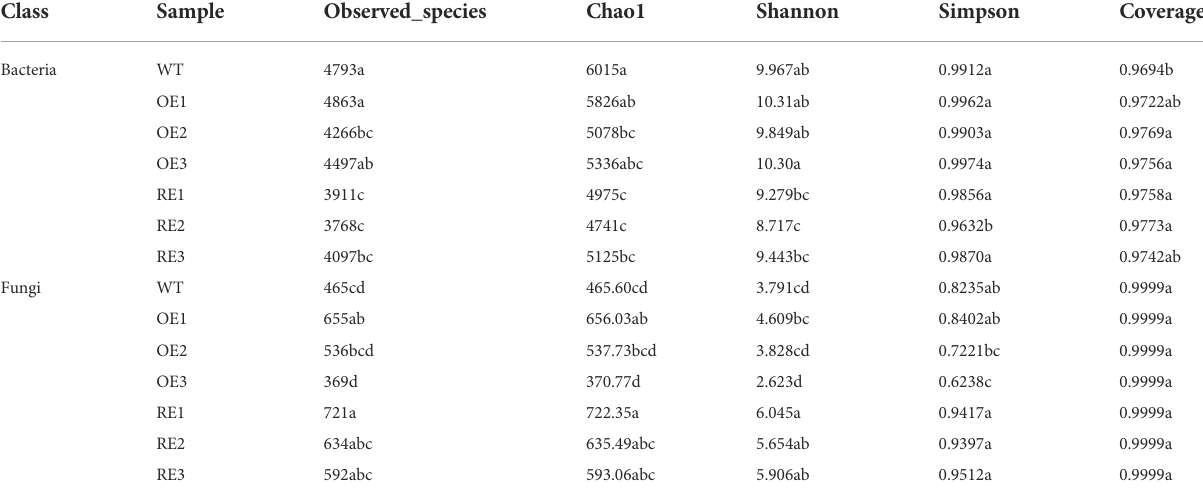
TABLE 1 Alpha diversity of bacteria and fungi in rhizosphere soil of transgenic PaGLK poplar.